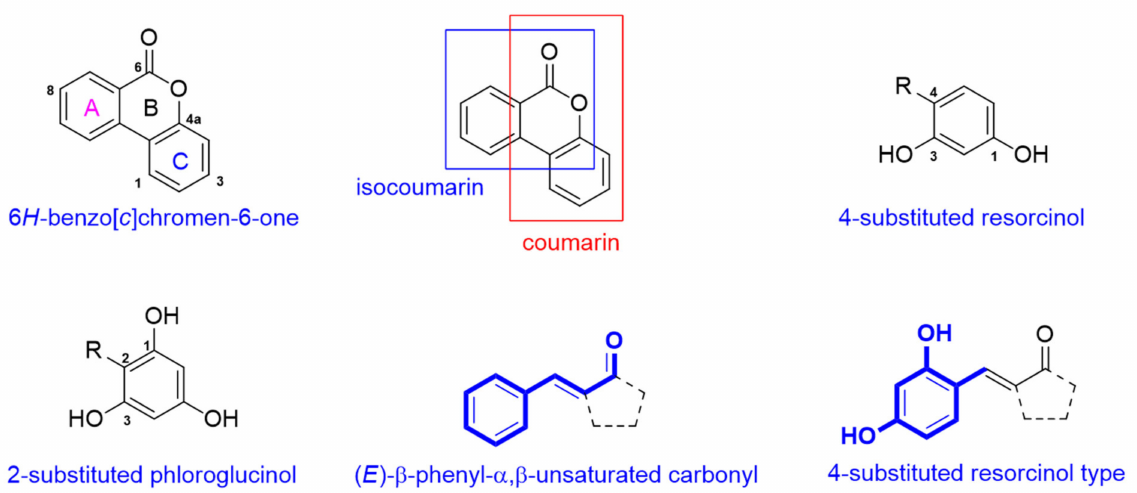
Figure 1. Templates for 6 H -benzo[ c ]chromen-6-one, isocoumarin, coumarin, 4-substituted resorcinol, 2-substituted phloroglucinol, ( E )- β -phenyl- α , β -unsaturated carbonyl, and 4-substituted resorcinol.